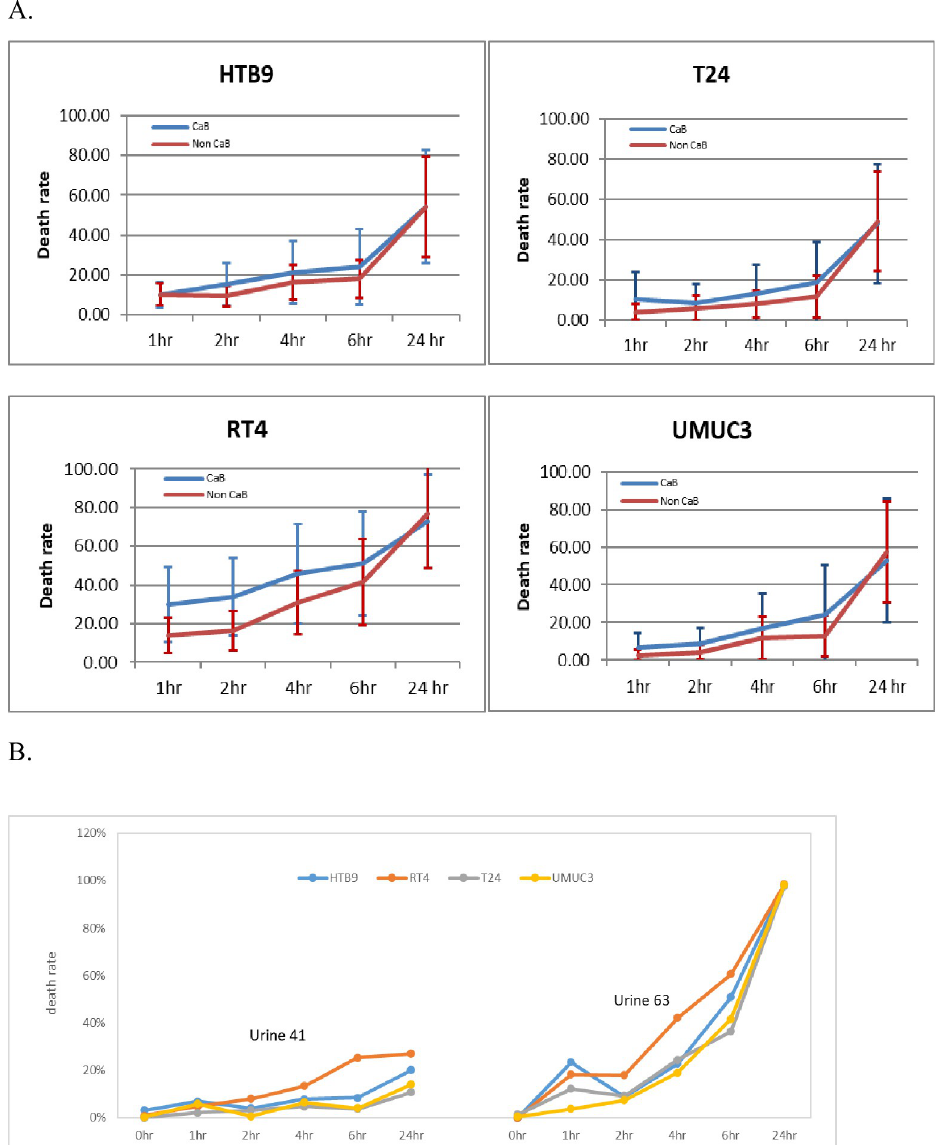
Fig 1. Urine toxicity on CaB cell lines by viability assay. (A) Four CaB cell lines HTB9, RT4, T24 and UMUC3 were tested. 23 CaB urine and 20 non-CaB urine were collected for the viability assay. 1x10(6) cells/ml suspensions were incubating with 0.22um filter sterile urine, and cells were counted at 1, 2, 4, 6 and 24 hours with Trypan blue stain. Data was presented as percentage of dead cells. (B) Two patient urines showed significant result, CaB urine U41 was the least toxic and non-CaB urine U63 was the most toxic to all four cell lines. All cells count were done in triplicate.